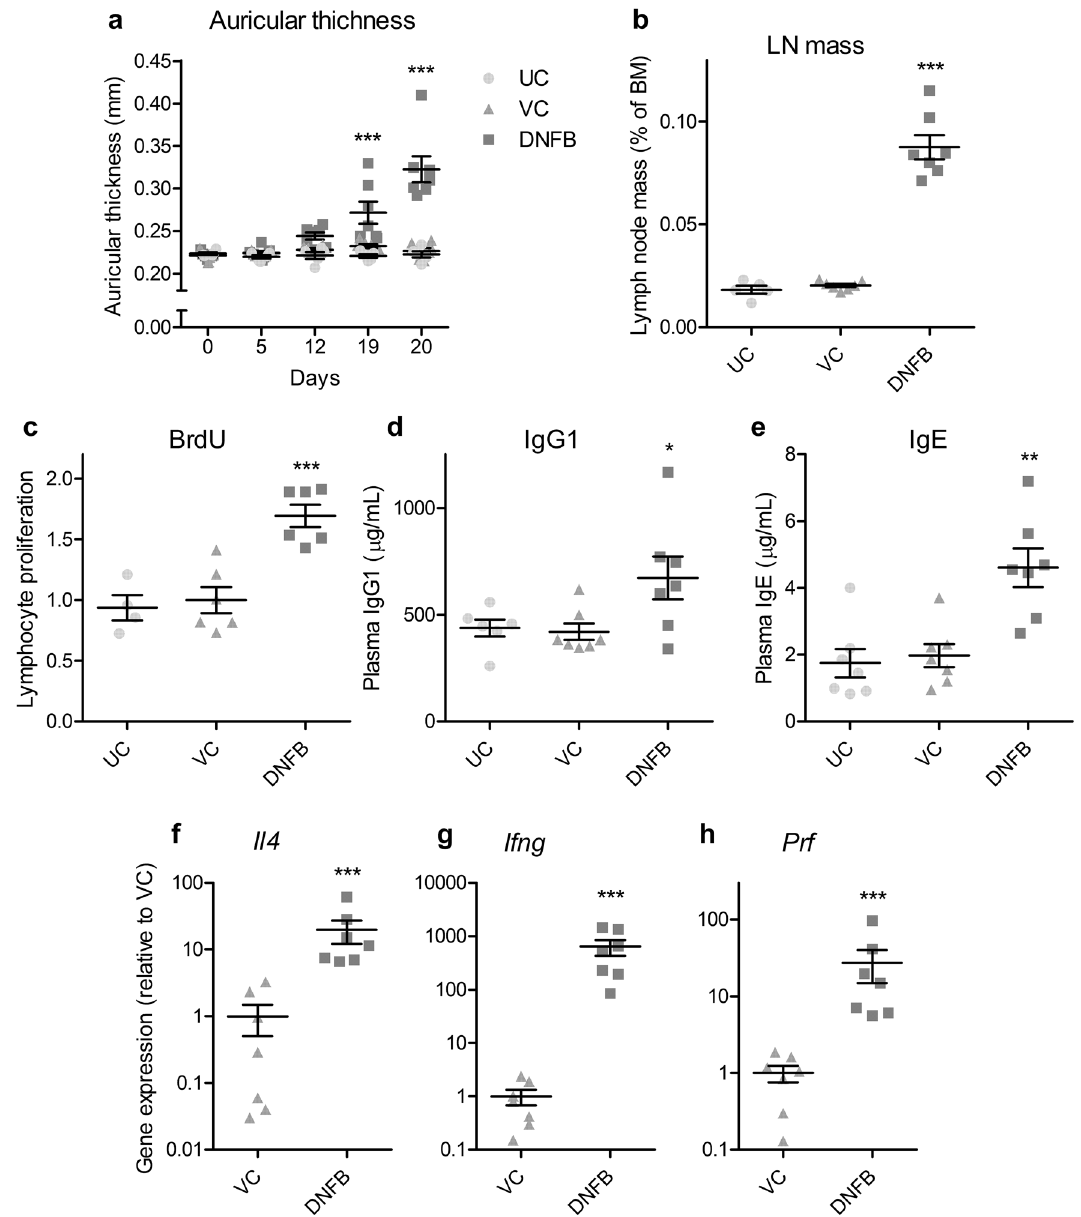
Figure 4. Changes in the auricle, auricular lymph nodes, plasma immunoglobulins, and auricular gene expression of mice after one DNFB induction and three challenges, 1 week apart. Left auricular thickness ( a ) was measured in the untreated (UC) and vehicle-only (VC) or DNFB-treated mice on days 0, 5, 12, 19, and 20 after induction. Auricular lymph node-to-body mass ratio ( b ) and BrdU-labeled lymphocyte proliferation in the lymph nodes ( c , ratio to vehicle control), including plasma IgG1 ( d ) and IgE ( e ), were also measured 24 h after the final treatment. Transcript levels of Il4 ( f ), Ifng ( g ), and Prf ( h ) in the auricle tissue of the vehicle-only (VC) or DNFB-treated mice were measured by real-time PCR using Actb as an internal control and expressed as ratios to the vehicle control. The graphs are scatter plots, where each symbol represents an actual measurement, and the centerlines and error bars represent the mean and standard error, respectively. Asterisks indicate levels of significant differences from the vehicle control: * P < 0.05, ** P < 0.01, *** P < control (Fig. 6b,c). In the auricular tissue of all TNCB-treated mice, the epidermis, dermis, and subcutaneous tissue were thickened, with characteristic edema, hyperemia, and inflammatory cell infiltration being observed in the thickened tissue. Nevertheless, there were no microabscesses as observed in DNFB. Protocol 3: local lymph node assay (OECD TG 442B). According to the OECD TG 442B, we meas- ured auricular thickness and lymphocyte proliferation by BrdU-labeling in the auricular lymph node. Three days after the last application, the auricular thickness of α-hexyl cinnamaldehyde (HCA)-treated mice increased